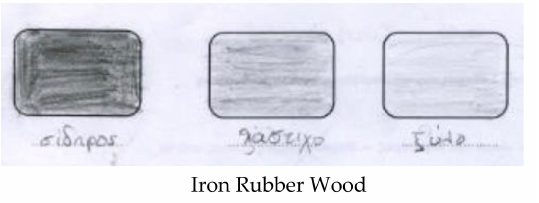
Figure 3. One of the students’ proposals to represent the “heavier-lighter” relationship of cubes of different materials, noted on the relevant